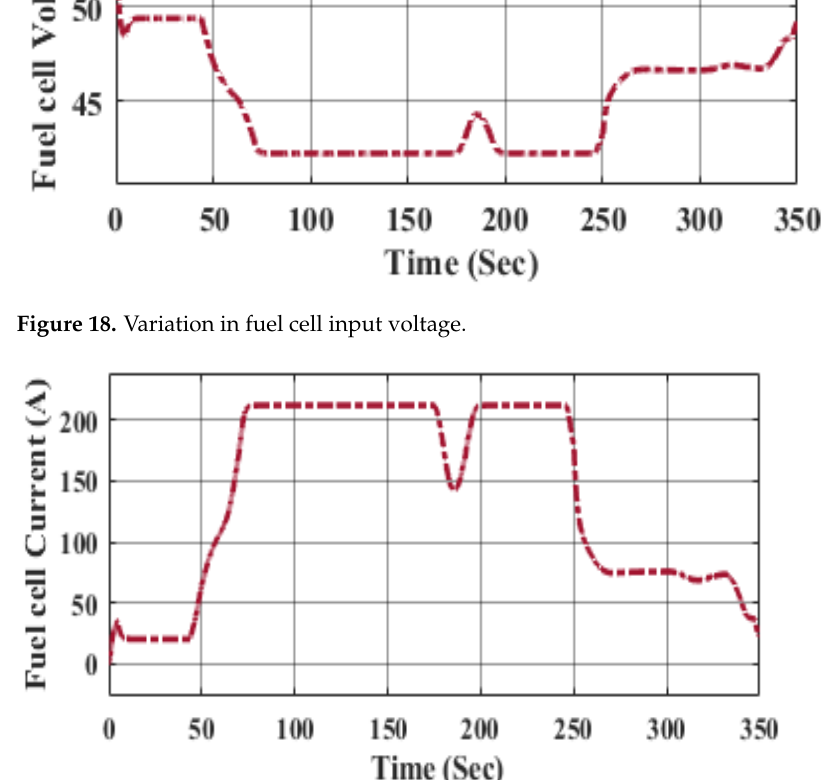
Figure 18. Variation in fuel cell input voltage.